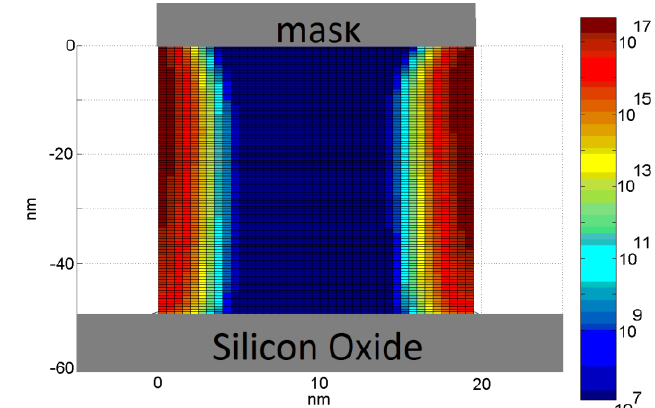
Fig. 4. Silicon recoil concentration (cm -3 ) in the 50 nm height fin